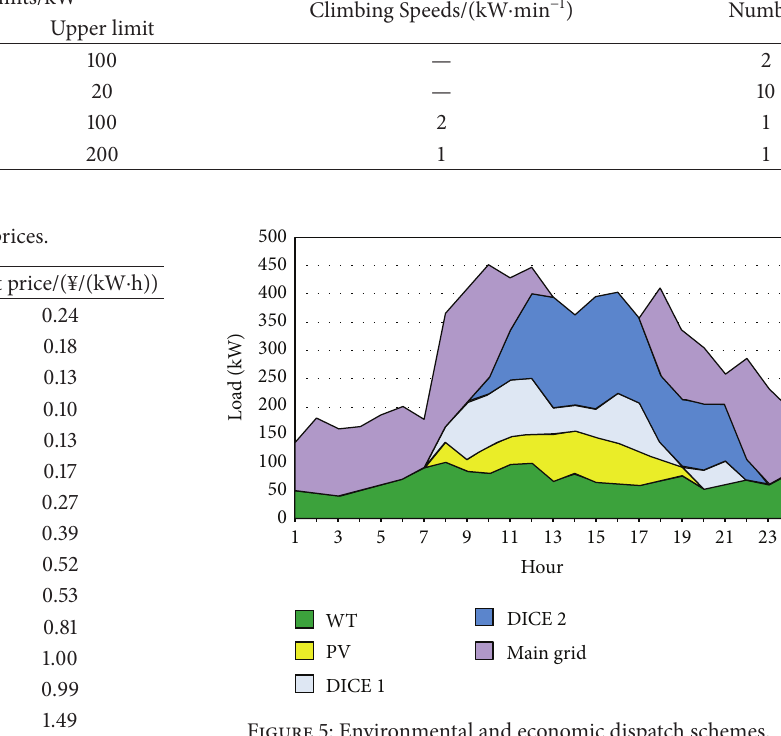
Table 1: Technical data of distributed generation units in SMG.